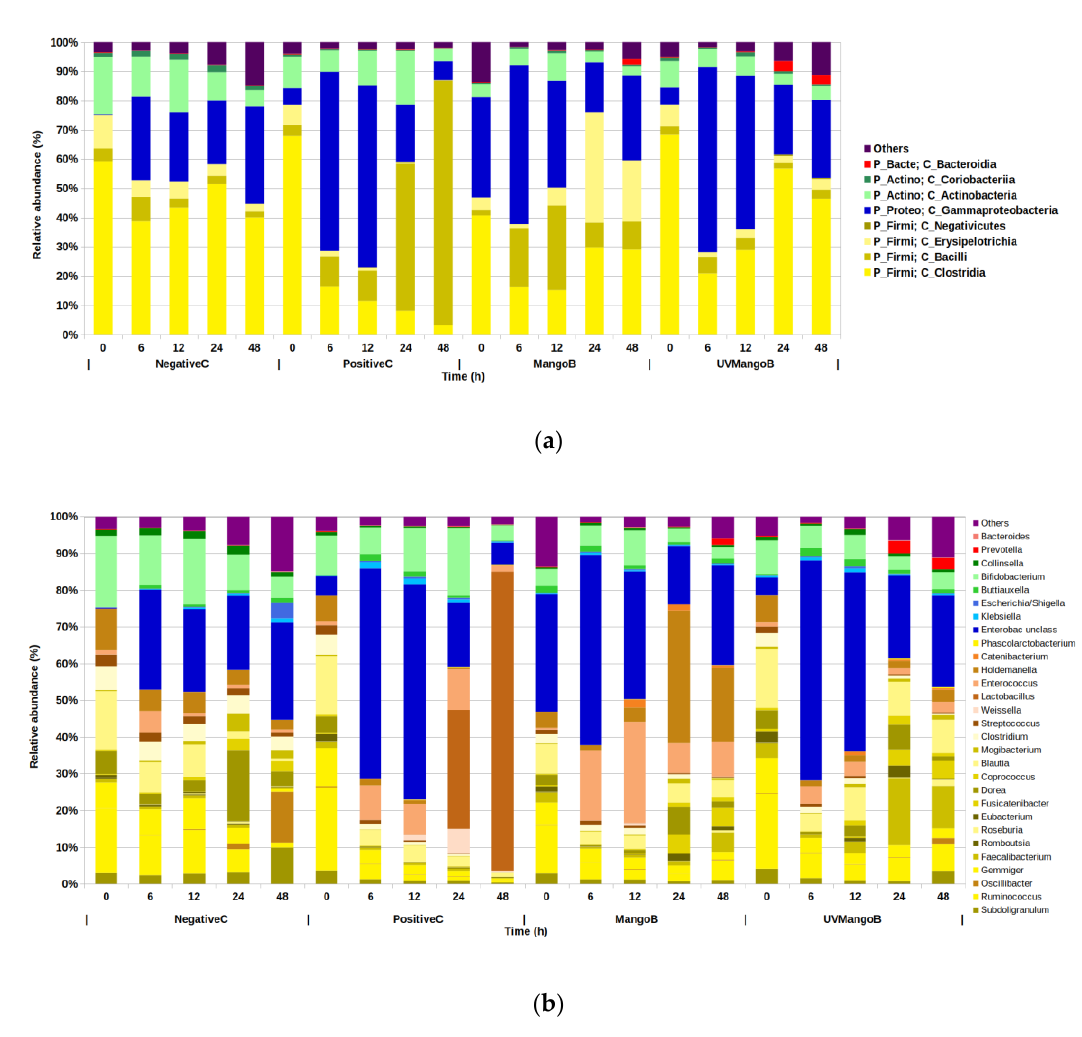
Figure 2. Relative abundance of bacterial composition determined by 16 s rRNA (V4-V5 region) Illumina sequencing at 0, 6, 12, 24 and 48 h of colonic fermentation in negative control (NegativeC), positive control (PositiveC), non UV-C irradiated mango bar (MangoB) and UV-C irradiated mango bar (UVMangoB) treatments. Percentage mean ( n = 3). ( a ) The most abundant phylum and class level are depicted by Firmicutes (yellow), Proteobacteria (blue), Actinobacteria (green), Bacteroidetes (red) and Others (purple). ( b ) At the genus level, di ff ering shades of phylum’s colors were applied. Genera > 0.05% of the total ASVs composition were considered for the graph.